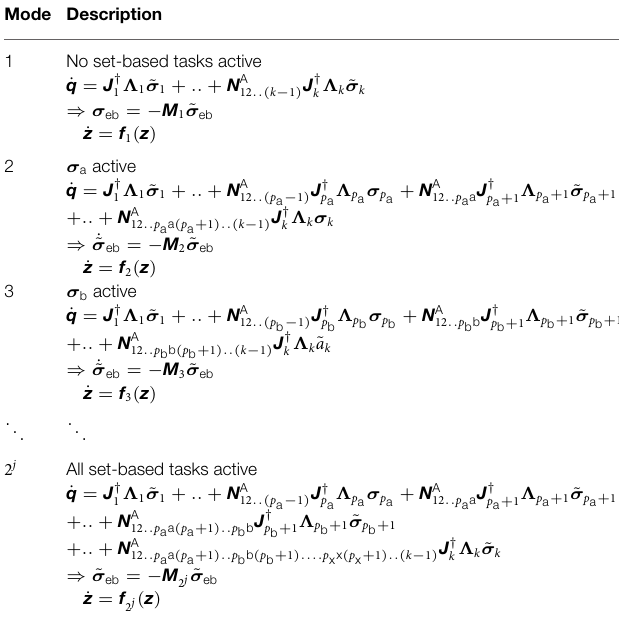
TABLE 2 | System equations for the resulting 2 j modes for j low-priority set-based tasks . Mode